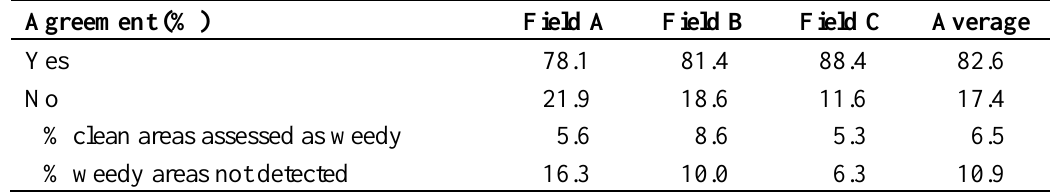
Table 1. Contingency table showing the frequency of points with similar information on weed presence/absence (% agreement) when comparing the optoelectronic mapping system with digital images assessed by image processing